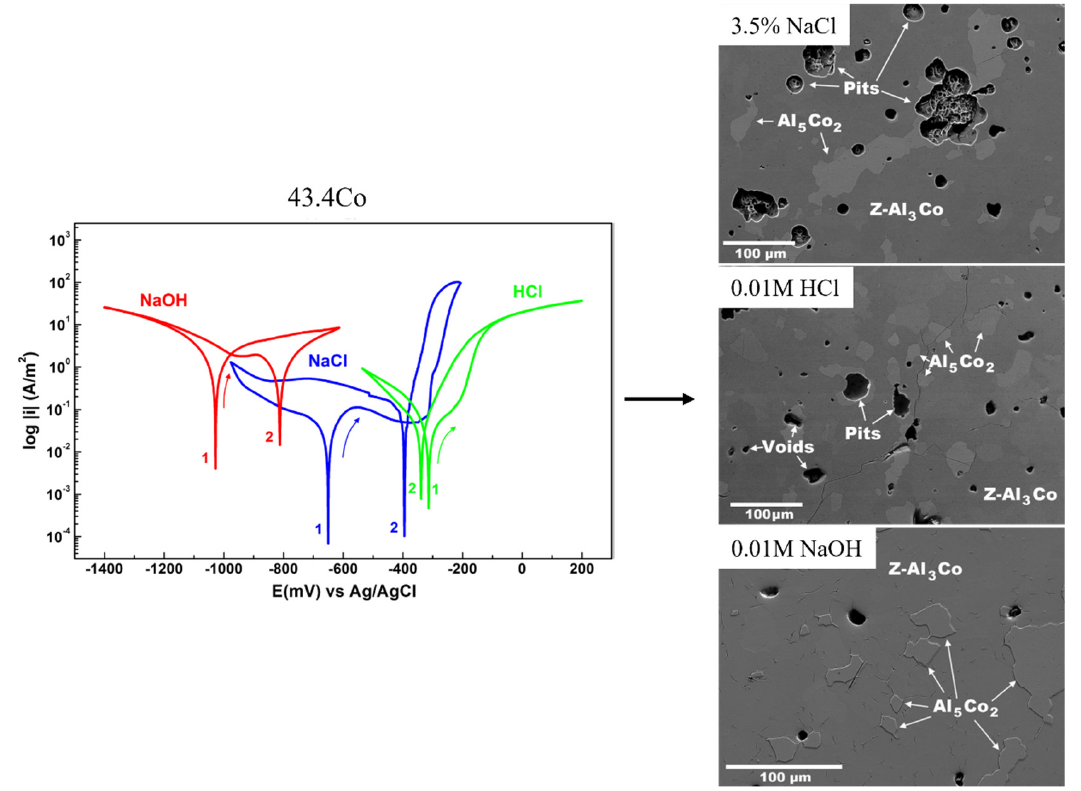
Figure 5. Potentiodynamic polarization curves for Al-43.4 wt % Co in 3.5% NaCl, 0.01M HCl, 0.01M NaOH and corroded surfaces under SEM after polarization (Reprinted with permission from [81], Copyright 2022, Springer Nature).